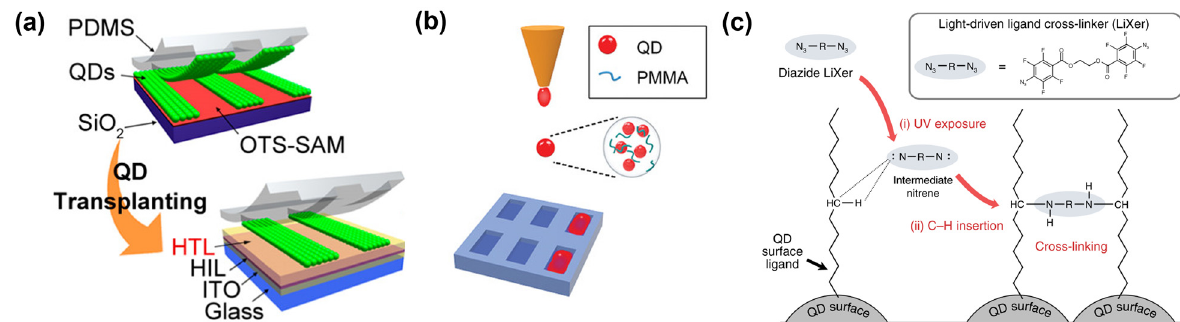
Figure 5. Schematic illustration of various QD patterning methods: ( a ) Contact transfer printing of QDs using a PDMS stamp (Reproduced from [129] with permission from American Chemical Society). ( b ) Inkjet printing of QD solution into subpixels (Reproduced from [130] with permission from Wiley). ( c ) UV-induced ligand crosslinking process for direct patterning of the QD film (Reproduced from [131] with permission from Springer Nature).